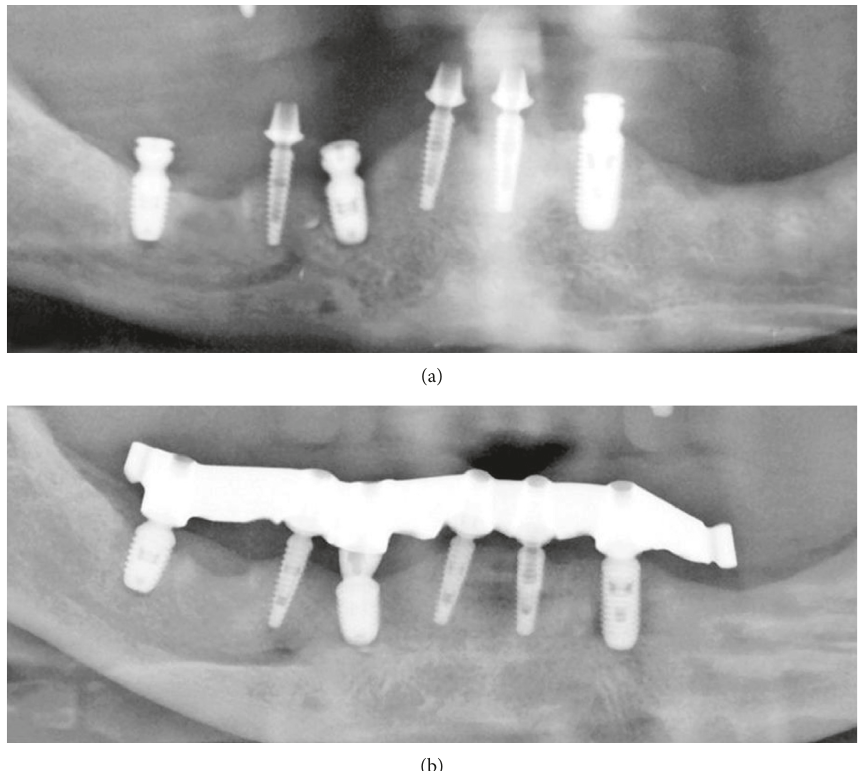
Figure 8: Mandibular OPG sections eight months postoperatively (not modified radiograph taken during current treatment). (a) After placement of three additional implants. (b) After bar